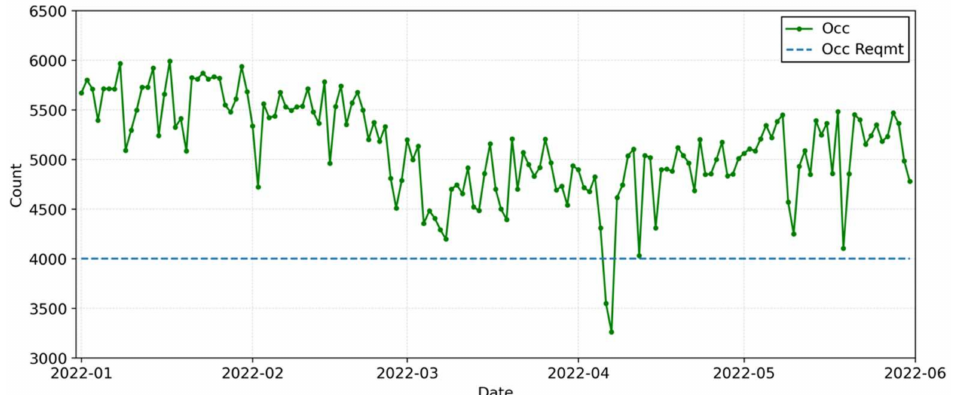
Figure 2. TGRS neutral atmosphere occultations per day passing QC in 2022.